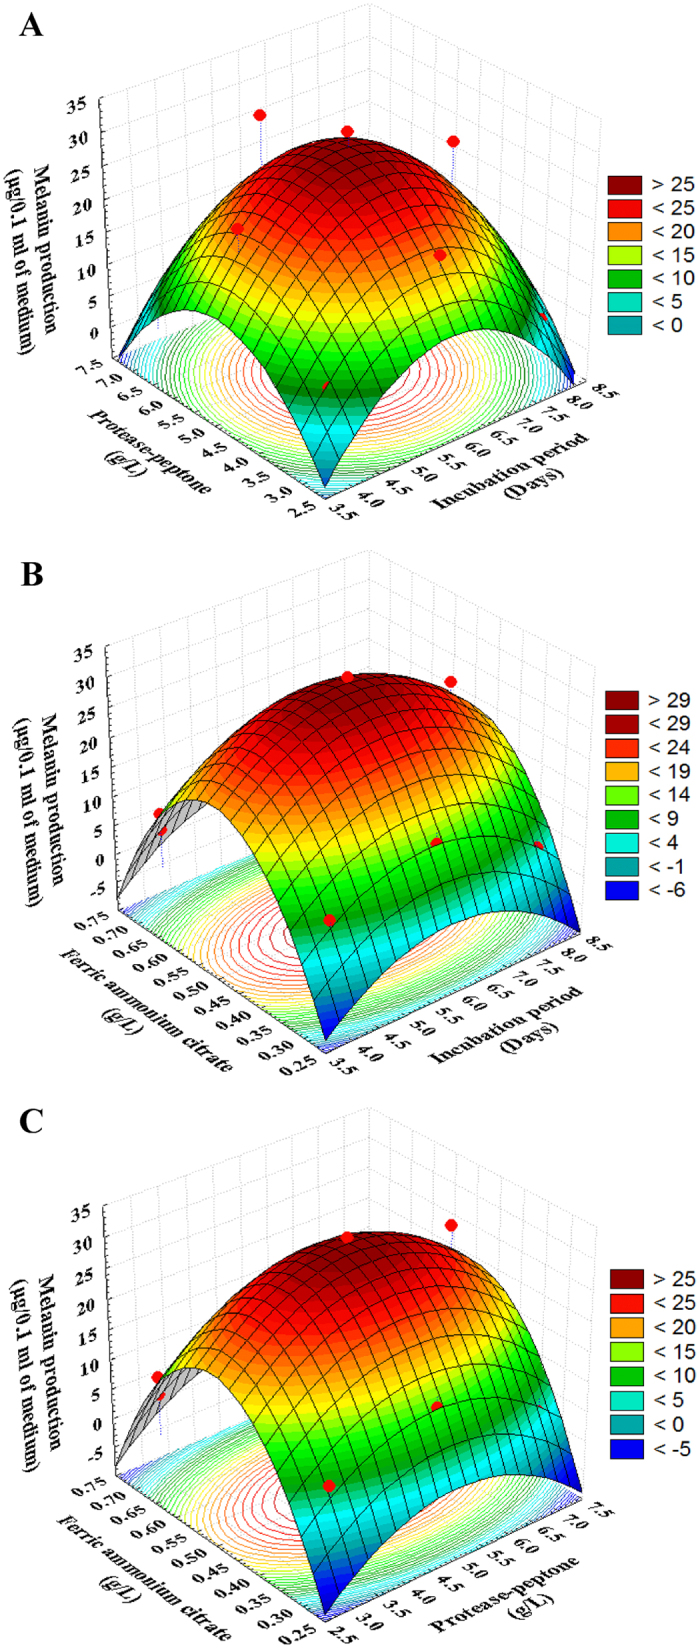
Three-dimensional response surface plots for melanin production showing the interactive effects of incubation period (X1), protease-peptone (X2) and ferric ammonium citrate (X3) when one of the variables is fixed at optimum value and the other two are allowed to vary.